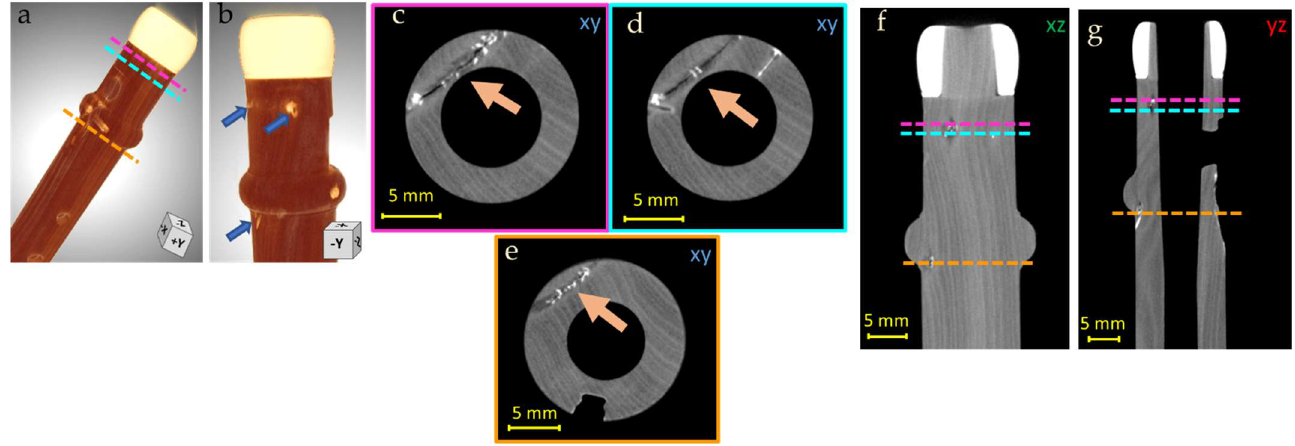
Figure 6. 3D render of the Piccolo Flute foot ( a,b ) with the indication of the illustrated features in the following pictures: CT horizontal ( c – e ), vertical ( f ) and lateral ( g ), slices of the Piccolo Flute, in which the fractures originating from the knots and their restoration are visible (orange arrows); in ( f,g ) colored lines correspond to the different fractures at different heights (colored contours of ( c – e )).